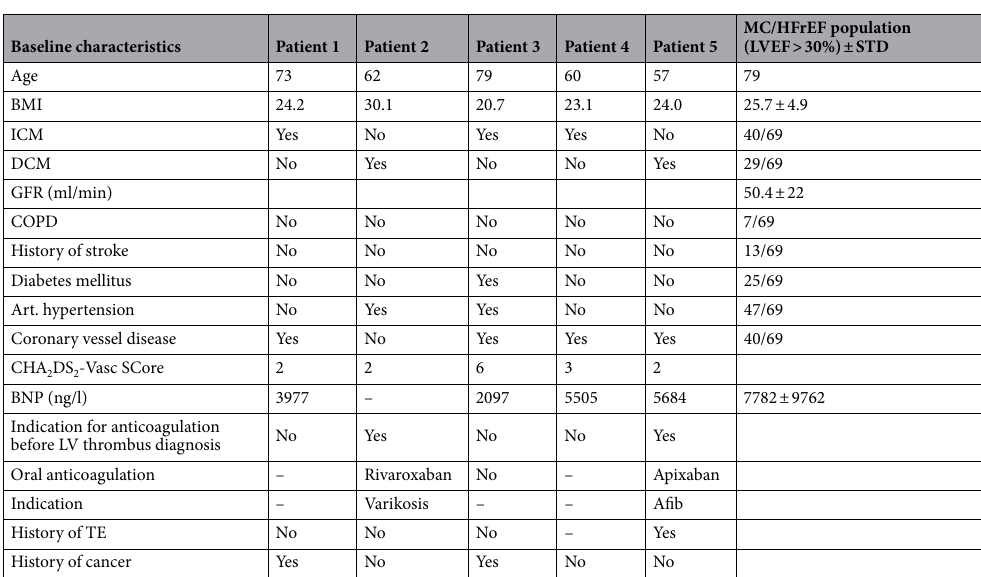
Table 3. Baseline characteristics of the patients diagnosed with LV thrombus and the cohort with severely impaired left ventricular systolic function. Afib atrial fibrillation, BMI – body mass index, ICM ischemic cardiomyopathy, DCM dilatative cardiomyopathy, COPD chronic obstructive pulmonary disease, GFR glomerular filtration rate, MC MitraClip.